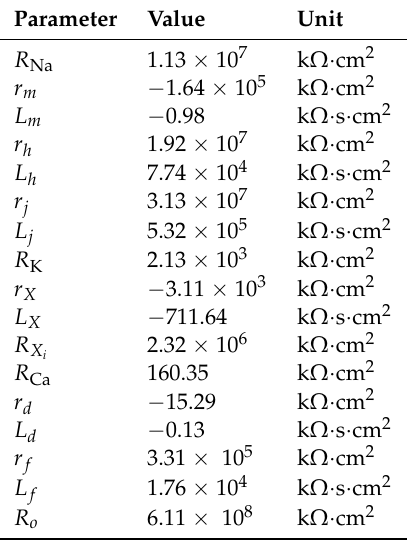
Table 3. Parameters used for membrane